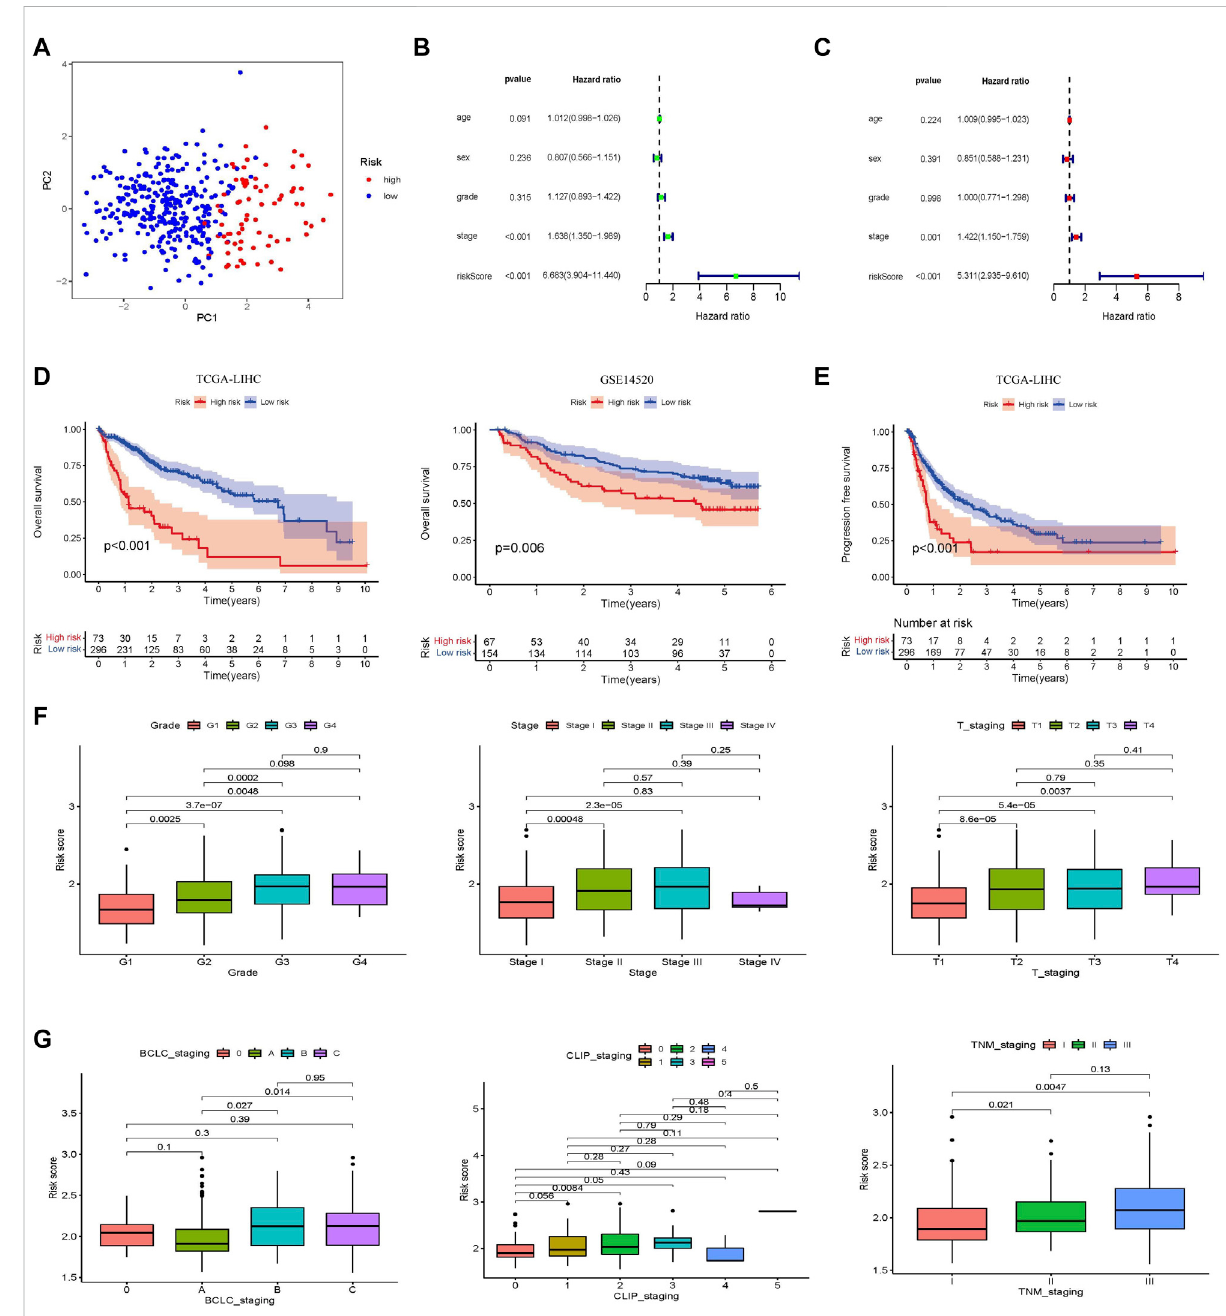
FIGURE 3 Establishment and validation of a prognostic risk score associated with glycometabolism. (A) Principal component analysis based on genes related to glycometabolism in patients with HCC. (B,C) Forest plot of univariate and multivariate Cox regression, respectively, in the TCGA-LIHC cohort. (D) Kaplan – Meier curve analysis comparing the overall survival between the low-risk and the high-risk groups of patients with HCC in the training andvalidation cohorts,respectively. (E) Kaplan-Meier curveanalysis comparing the progression-free survival between the low-risk and high-risk groups ofpatients with HCC in theTCGA-LIHC cohort. (F) Comparison of therelationship between different glycometabolism-related risk scoresandclinicalstagesintheTCGAcohort. (G) Comparisonoftherelationshipbetweendifferentglycometabolism-relatedriskscoresandclinical stages in the GEO